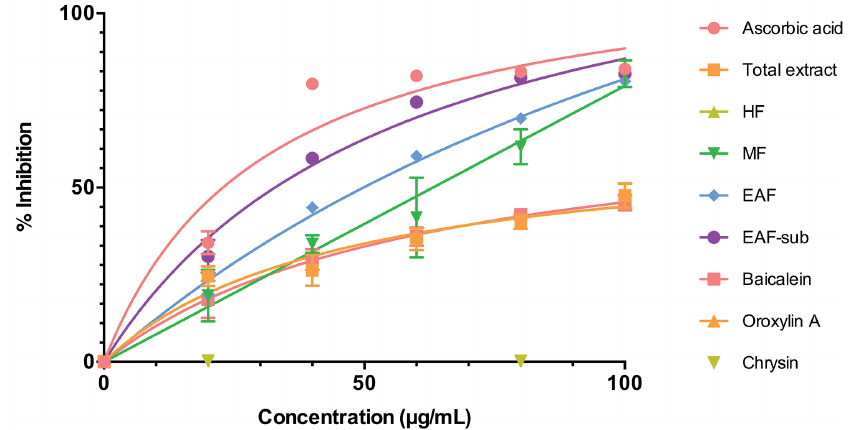
FIGURE 2 - DPPH free radical inhibiting activity (%) at various concentration of the total extract, hexane (HF), methanol (MF) and ethyl acetate (EAF) fractions, sub-fraction of ethyl acetate fraction (EAF-sub), baicalein, oroxylin A, chrysin and ascorbic acid. - not determined . Each point represents the Mean ±